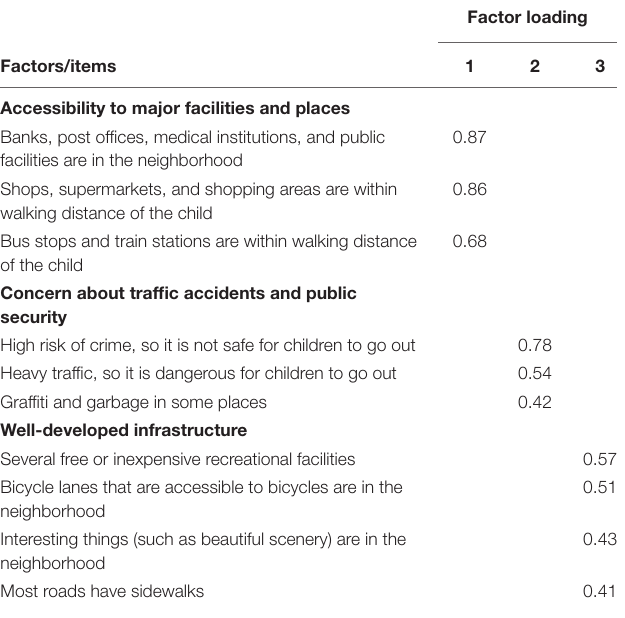
TABLE 9 | Factor loadings for neighborhood